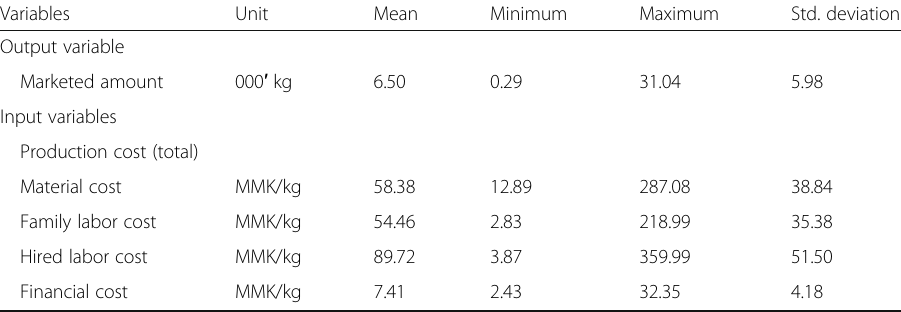
Table 6 Descriptive statistics of the output and input variables of the rice farmers ( N = 130)